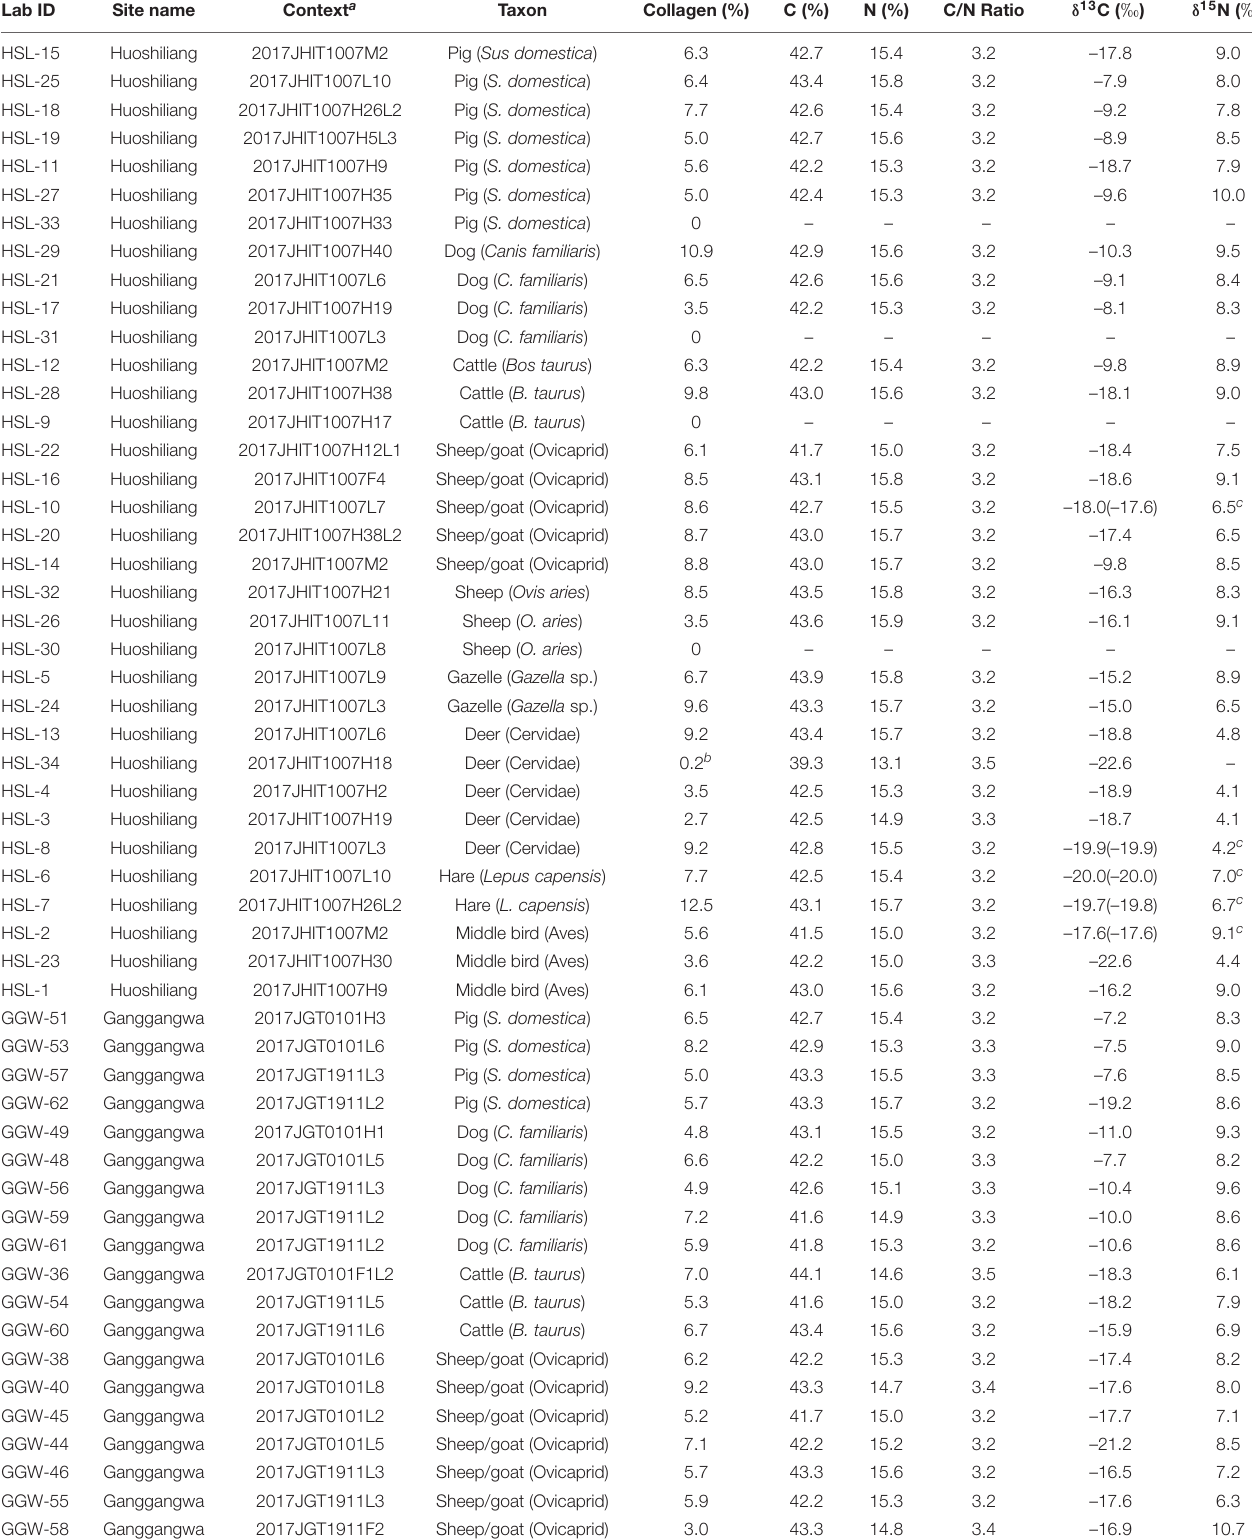
TABLE 1 | Stable carbon and nitrogen isotope and quality indicator measurements of animal bone collagen from Huoshiliang and Ganggangwa sites. Lab